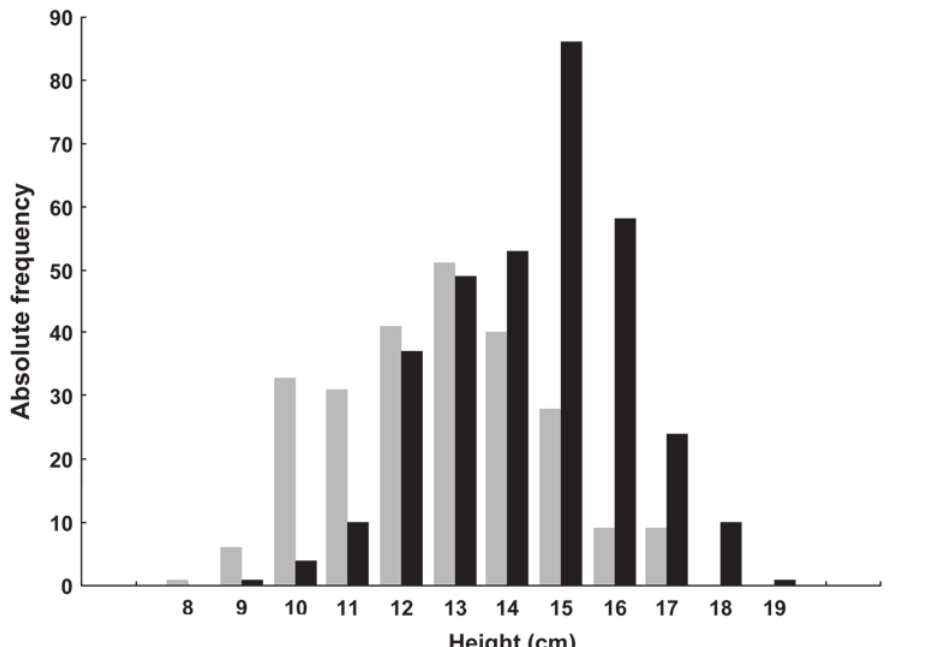
Fig. 3. Occurrence of dorsolateral spots according to height in males of Hippocampus reidi . Males presenting dorsolateral spots (black bars); males without dorsolateral spots (grey bars).